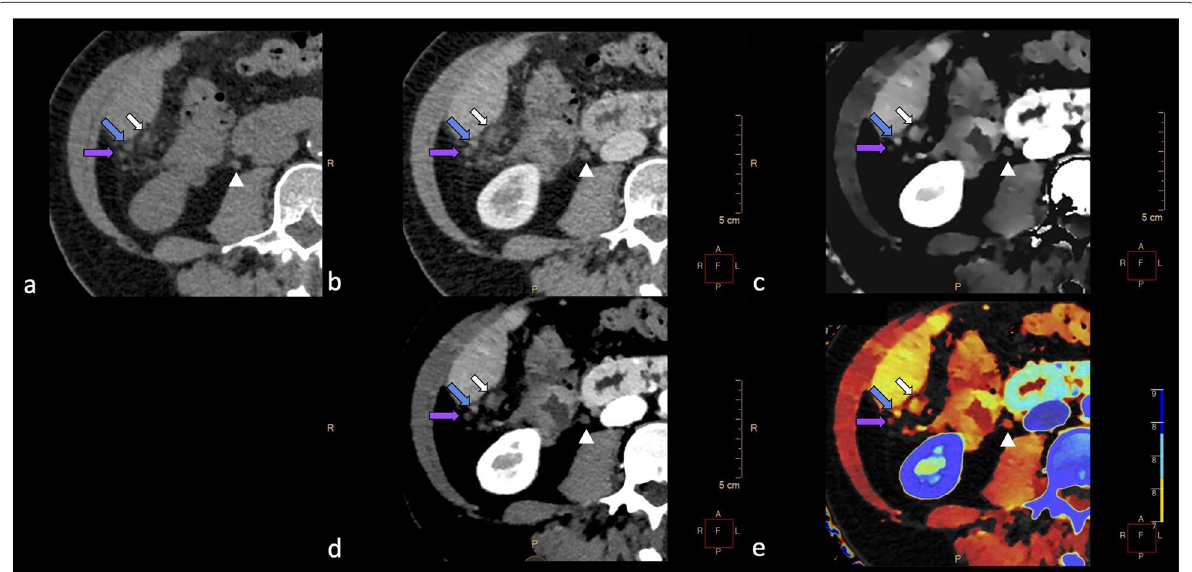
Fig. 1 a – e Spectral computed tomography of a 64-year-old woman with peritoneal carcinomatosis from ovarian cancer. In the native CT scan, obtained before the intravenous administration of contrast agent ( a ) and in the portal-venous phase ( b ), two small and almost apparently identical subhepatic nodules (purple and blue arrows) and a large peritoneal carcinomatosis lesion (white arrow) can be seen. Please also note a small paracaval lymph node (arrowhead), benign in appearance. Iodine density map ( c ), 40 keV monoenergetic image ( d ), and Z-effective image ( e ), obtained at the same level of image b ; the two small subhepatic nodules present different appearances. While the blue arrow nodule is similar to the large peritoneal carcinomatosis lesion (white arrow), the purple arrow nodule is similar to the small benign para-caval lymph node (arrowhead). This could suggest a different nature of these nodes: the blue arrow one is more likely to be a peritoneal carcinomatosis node, and the purple arrow node is instead more likely to be a small peritoneal lymph node or a fibrotic